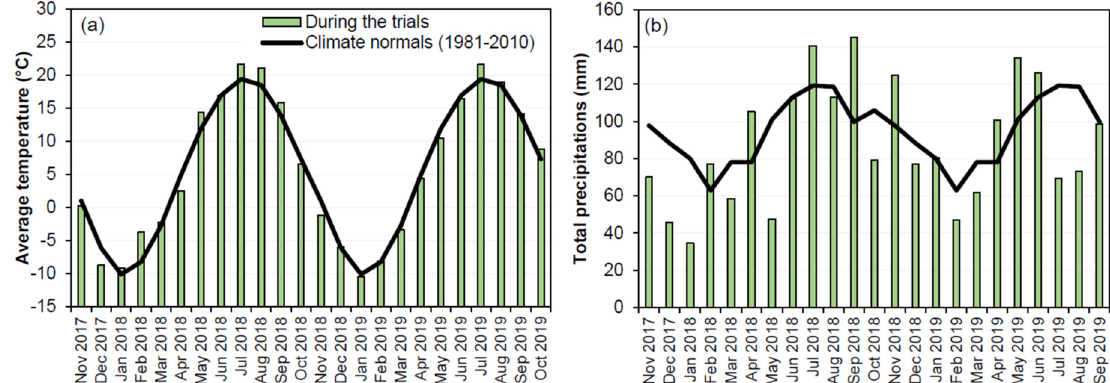
Figure 2. ( a ) Average monthly temperatures; and ( b ) total monthly precipitations during the firewood seasoning trials in comparison to 30 years climatic normals. Data were taken from the nearest meteorological station (Magog, QC, Canada). Precipitation data for October 2019 are not shown because an extreme rain event occurred on 31 October (79 mm) after the last moisture content sampling in Trial B (22 October 2019).